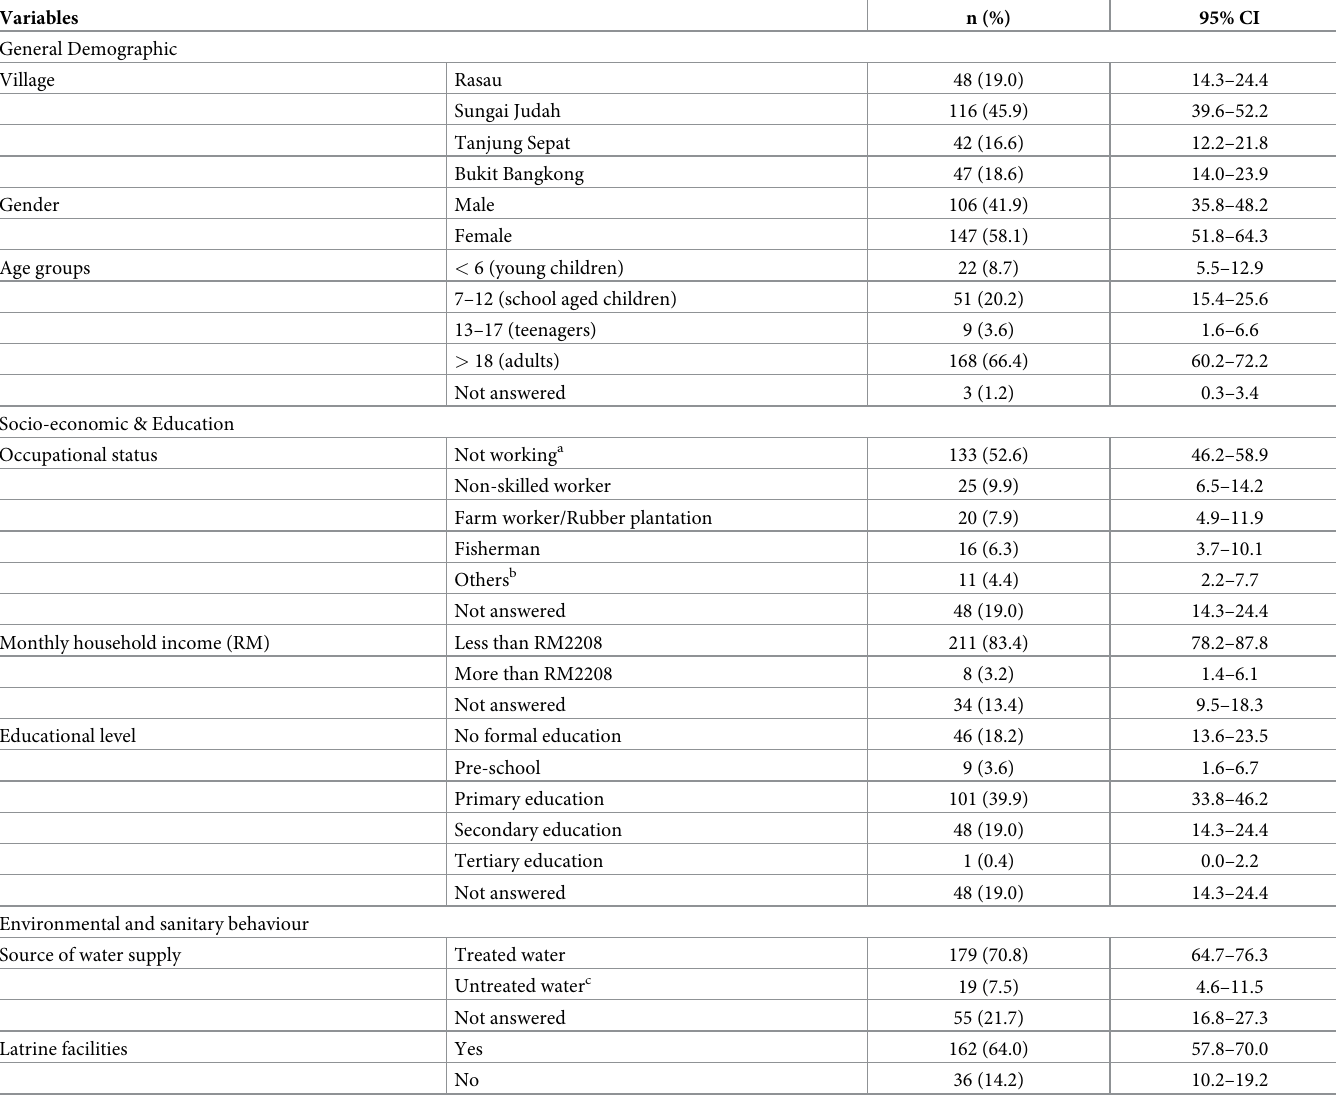
Table 1. Demographic profiles, socio-economic, environmental and sanitary behaviour characteristics of study